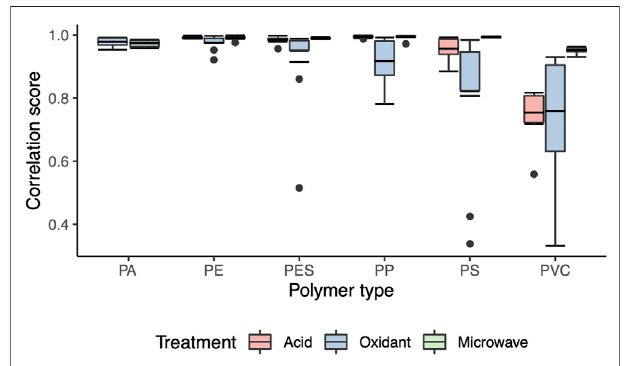
FIGURE 7 | Correlation score distribution of all recovered polymers for each treatment. PA* — polyamide, PE — polyethylene, PES — polyester, PP — polypropylene, PS — polystyrene, PVC — polyvinyl chloride. * PA was not able to be recovered from the acid treatment and thus this data is